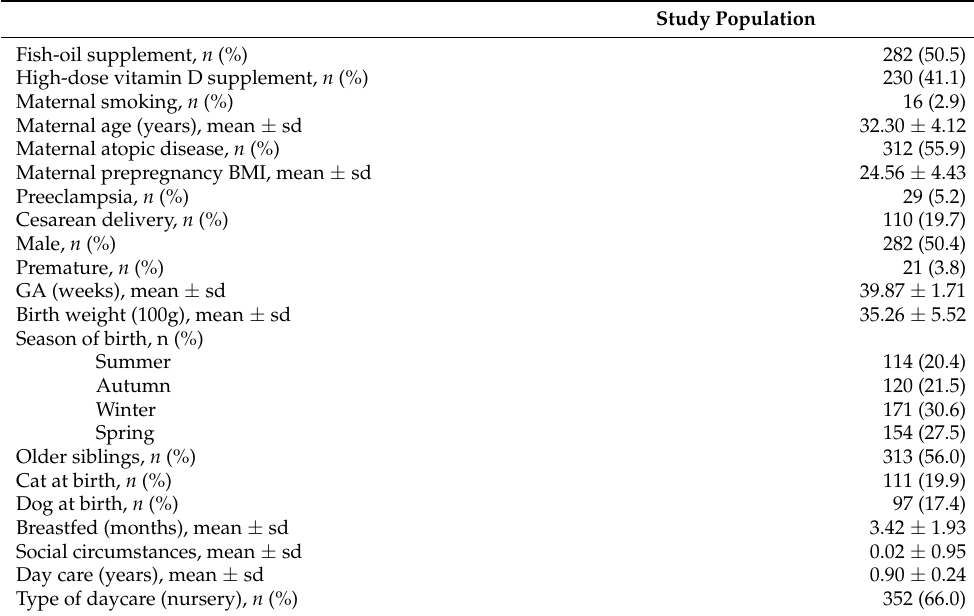
Table 1. Baseline characteristics of the study